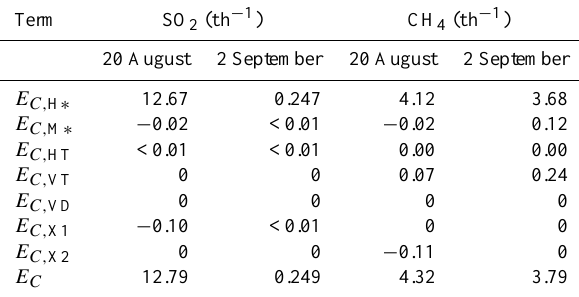
Table 6. Mass-balance terms for SO 2 and CH 4 (Eq. 7 and Table